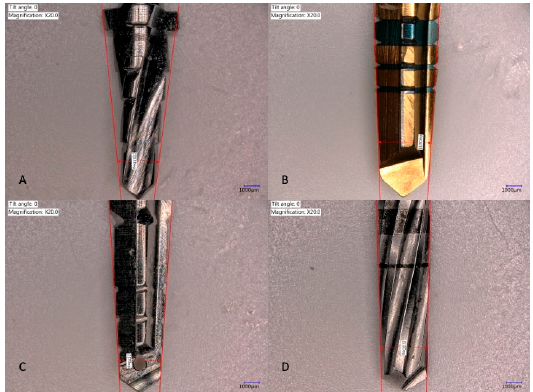
Figure 3. Drill wall angles. Composition image of the four drills used in this experiment. ( A ) Anker tapered drill walls, angle: 13 degrees; ( B ) Megagen tapered drill walls, angle: 5 degrees; ( C ) Nobel Biocare Tapered drill walls, angle: 7 degrees; and ( D ) Densah tapered drill walls, angle: 3 degrees.